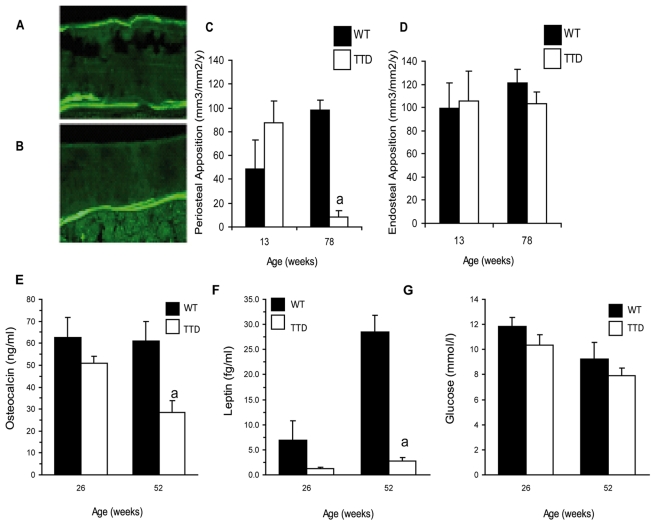
Periosteal apposition, bone formation and hormone levels.TTD mice lack periosteal apposition at 78 weeks whereas endosteal apposition is not affected. Calcein labelling at sites of periosteal apposition in 78-week-old (A) wild type and (B) TTD mice. Quantitative analyses of (C) periosteal and (D) endosteal apposition at 13 and 78 weeks. Serum measurements of bone formation markers and hormones; (E) osteocalcin, (F) leptin, (G) glucose at 26 and 52 weeks. Statistics: student t-test a = p<0.05 wild type vs. TTD. Error bars represent SEM.